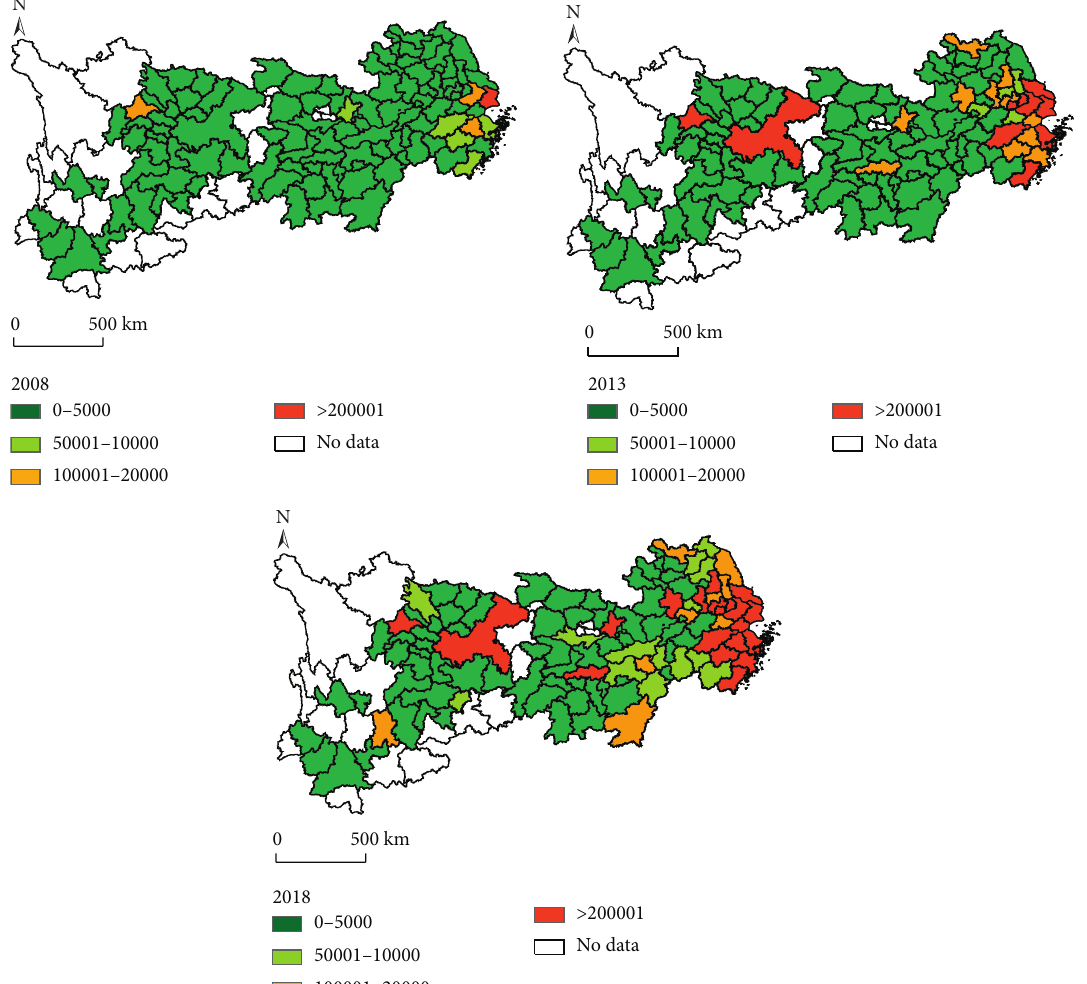
Figure 1: Spatial agglomeration of innovation output in YREZ in 2008, 2013, and